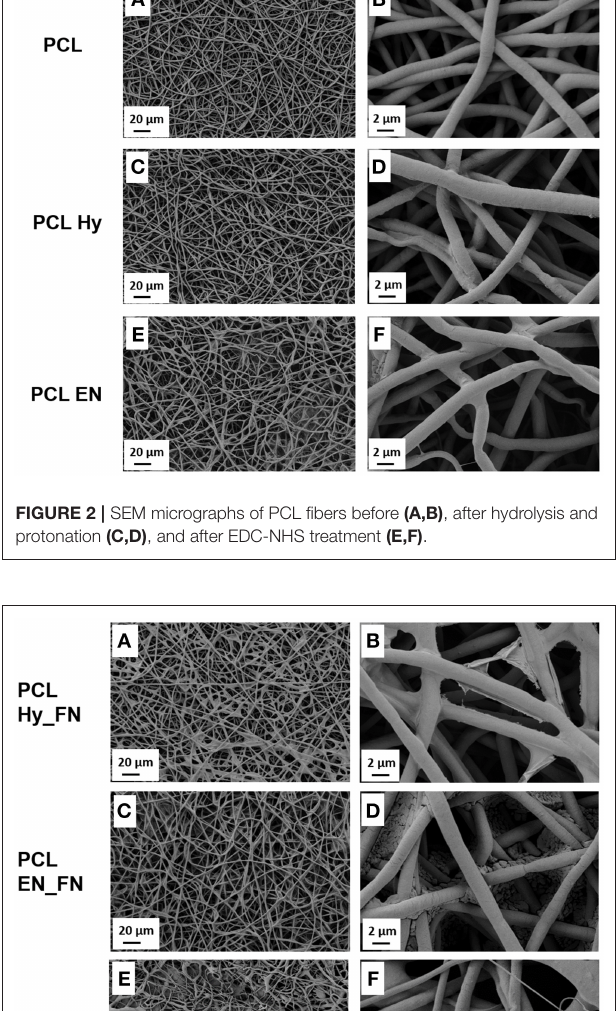
to the presence of fibronectin. Similar roughness on the fibers surface was already reported in literature (Chutipakdeevong et al., 2014) and related to the functionalization with fibronectin. For PCL EN_FN it was not possible to detect similar morphology on the top of the fibers, but some deposits are visible and they could be related to EDC-NHS treatment and the following fibronectin functionalization. The coaxial sample also showed fibrillary morphology but the average fiber diameter is not homogeneous as for the neat PCL mats and on the top of the fibers is not possible to detect any deposit which could be comparable with the sample PCL